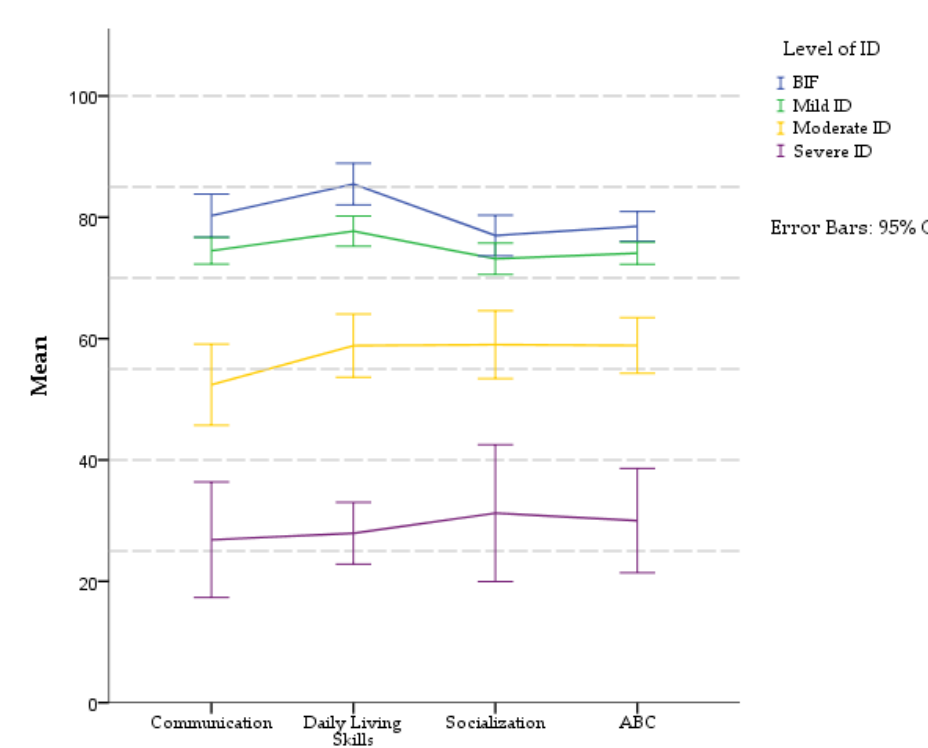
Figure 1. Profiles of AB domains (VABS-3) in different levels of ID. Standard scores: M = 100, SD = 15